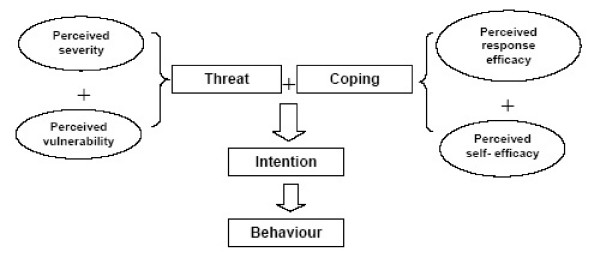
Flow chart of Protection Motivation Theory.